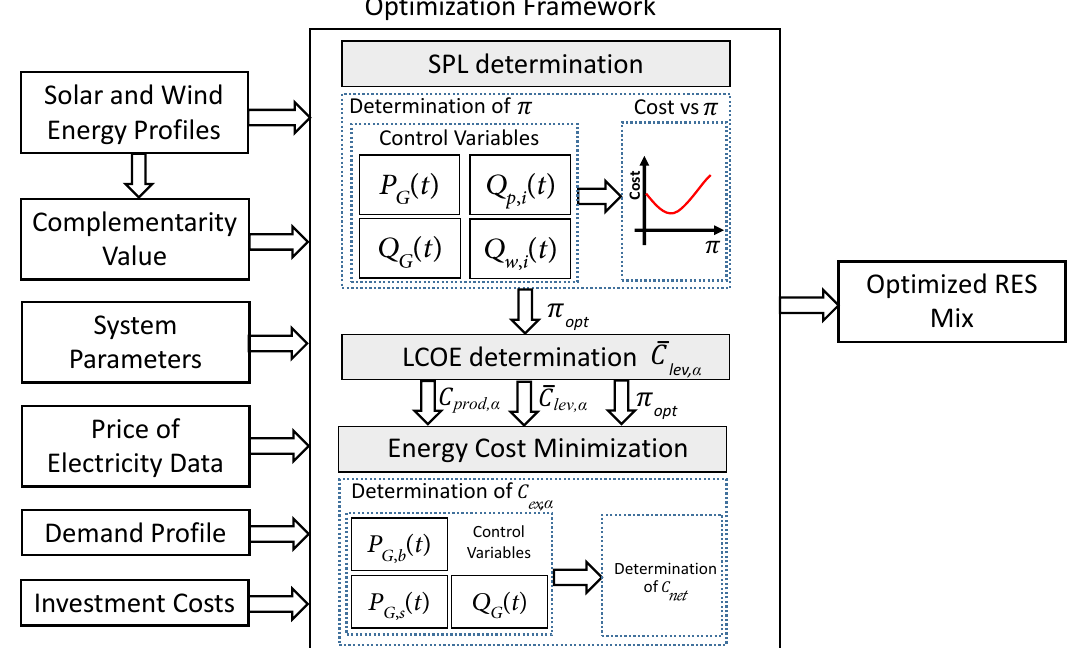
Figure 4. Block diagram showing the proposed